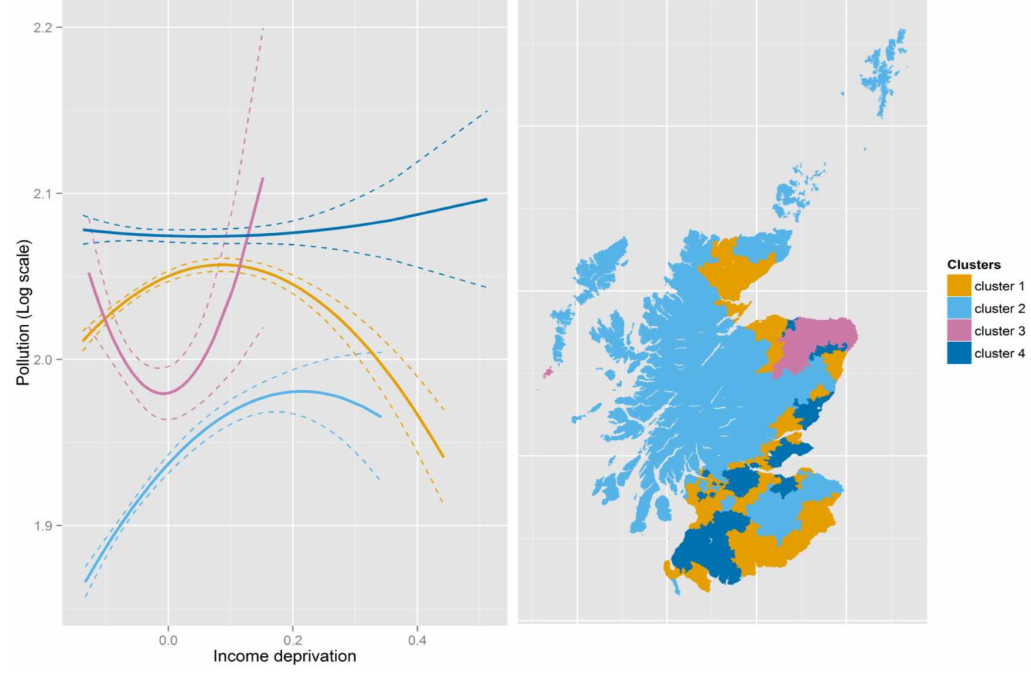
Figure 6. Pollution–deprivation relationships for the clusters in 2012. Note: The dashed lines are the approximate 95% confidence